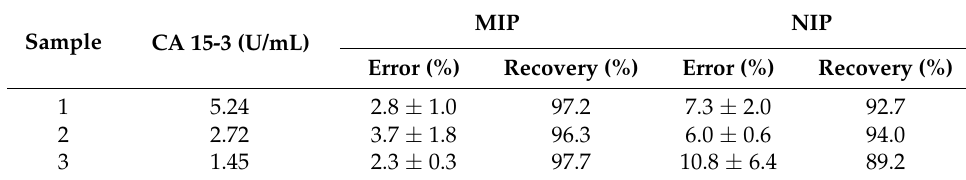
Table 6. Analytical response of the ISEs to spiked serum samples, after previous calibration in Cormay serum HM as background